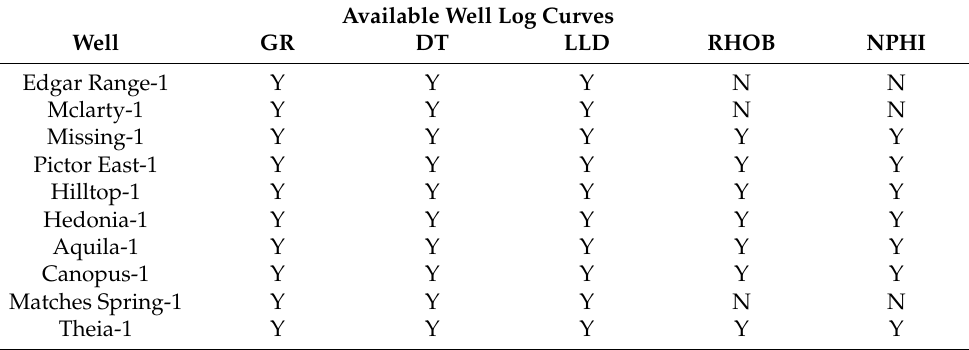
Figure 1. ( a ) Location of the prospective Canning Basin along with its tectonic elements and proven major oil and gas occurrence. The main area of interest of unconventional shale reservoir is within the onshore Broome Platform are shown in red colors (modified from [55]). ( b ) Generalized stratigraphy map of Canning Basin where the study unit is highlighted by a black dotted rectangle in the Ordovician (modified from [56]). Table 1. The list of well log curves of the selected ten wells. Y indicates the log curve is present where N is non ‐ existence of that curve. Edgar Range ‐ 1, Mclarty ‐ 1, and Matches Spring ‐ 1 do not have RHOB and NPHI curve.